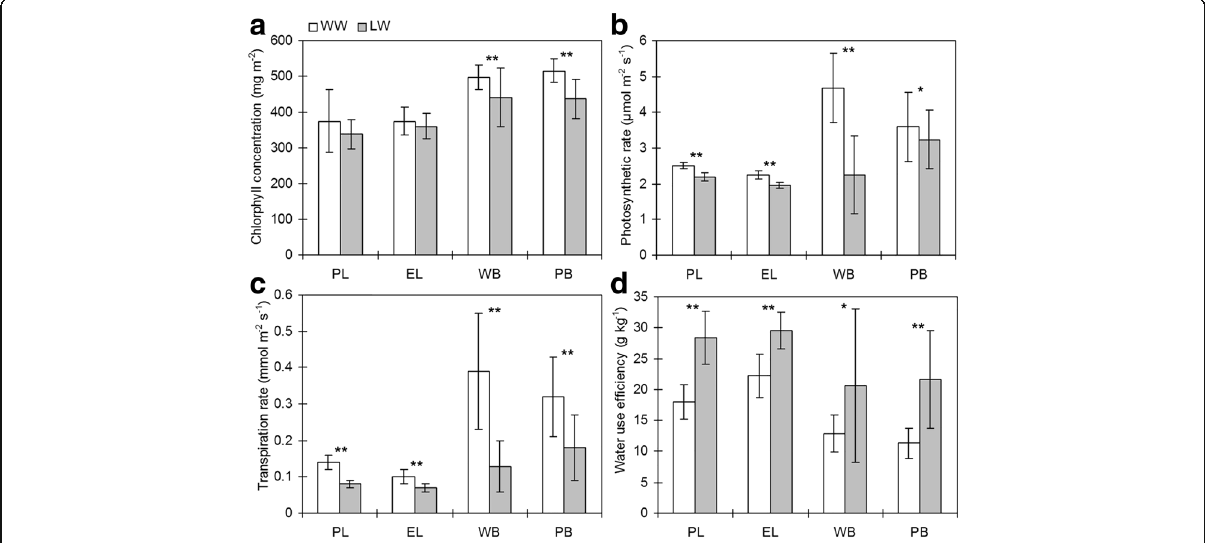
Fig. 5 Photosynthesis capacity of four species treated by two water treatments. a : Chlorophyll concentration (mg m -2 ), b : Photosynthetic rate (umol m -2 s -1 ), c : Transpiration rate (mmol m -2 s -1 ), d : Water use efficiency (g kg-1). PL: Prince Rupprecht ’ s larch, EL: eastern larch, WB: white